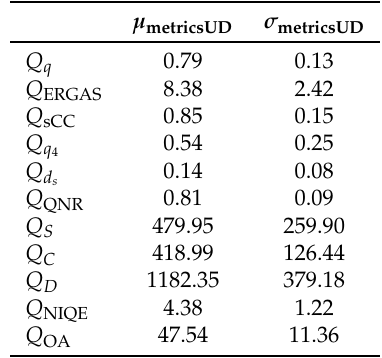
Table 3. Means and standard deviations of quality scores from 11 reduced resolution and full-resolution quality metrics. In this case, each algorithm analyzed 35 PS undistorted images (6 PS algorithms + EXP) in five different scenarios.